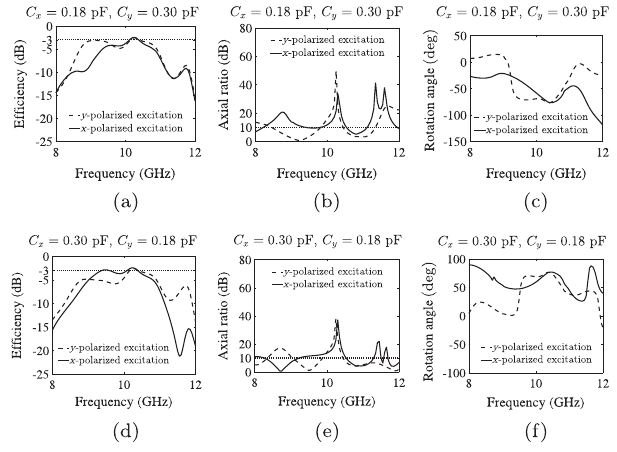
FIG. 8. Simulation results for the polarization rotator under x - and y -polarized incident